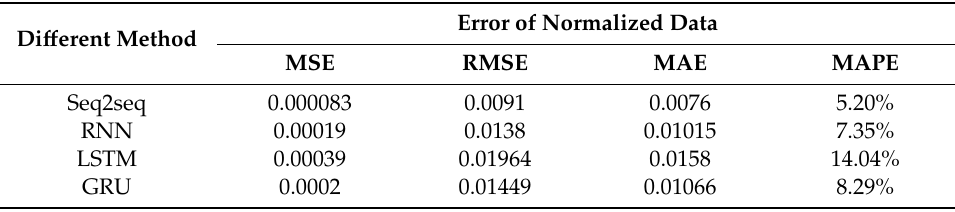
Table 3. The comparison of prediction errors of normalized data under different algorithms.